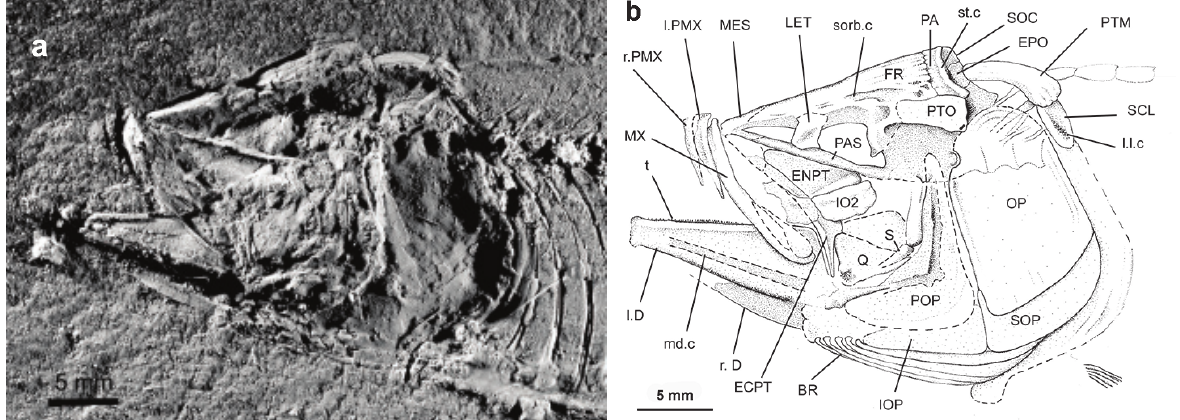
Figure 2. † Scutatuspinosus itapagipensis Santos and Corrêa 1985: ( a ) head in left lateral view (DGM 1164-P); ( b ) interpretative line drawing of DGM